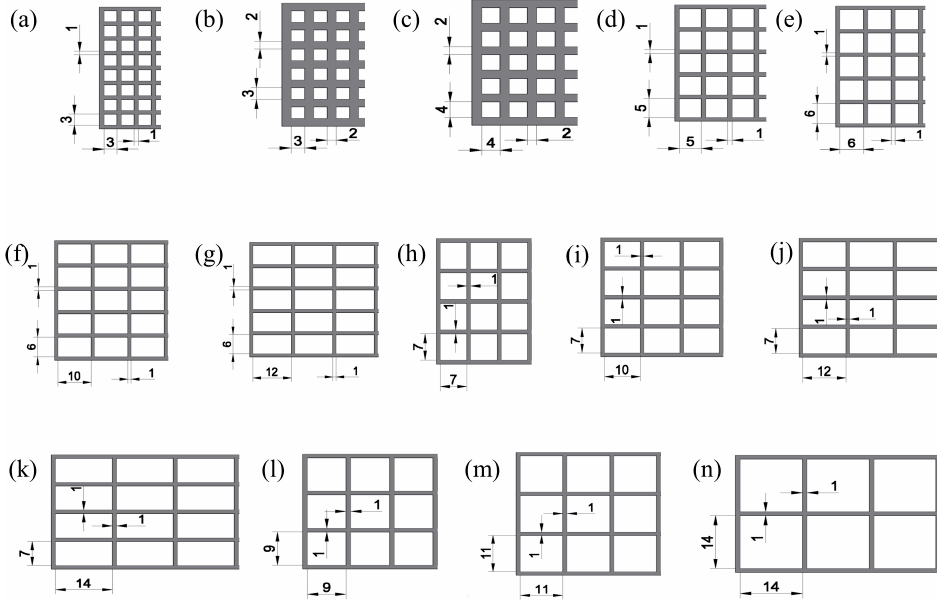
Figure 4. Sketch view of the section model in the test section and the body-height grid in the flow inlet.